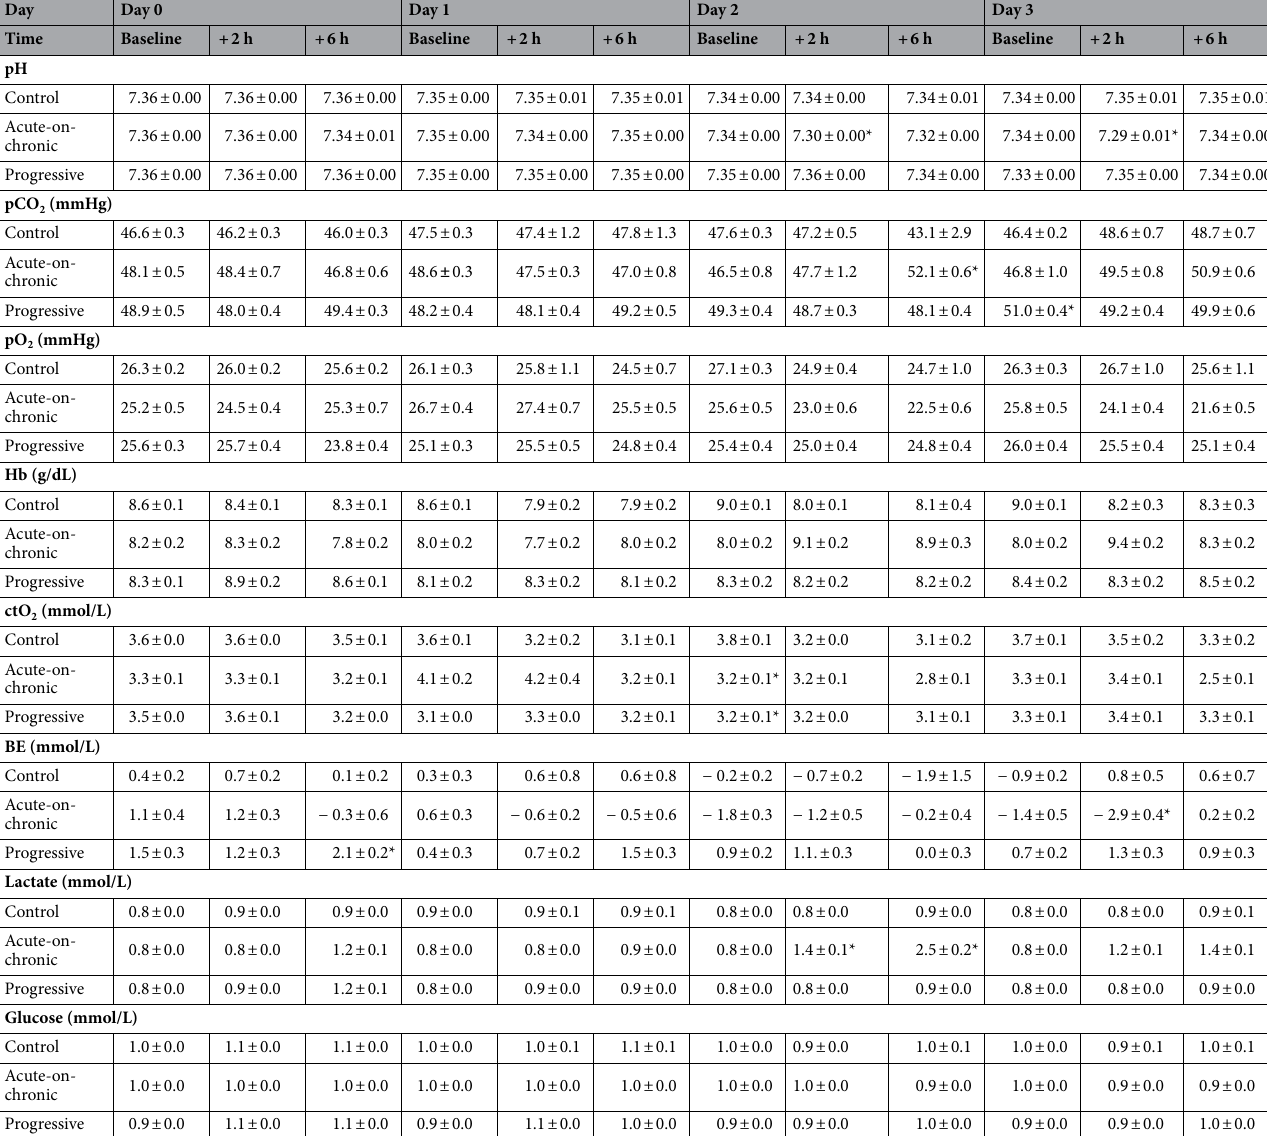
Table 1. Arterial biochemistry from day 0 to day 3. pCO2 partial pressure of carbon dioxide, pO2 partial pressure of oxygen, Hb hemoglobin, ctO 2 oxygen content, BE base excess. *p < 0.05 vs.